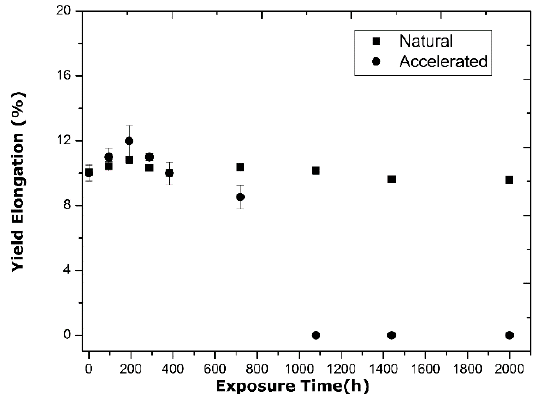
Figure 7. The yield elongation as a function exposure time for natural and accelerated photoaging.